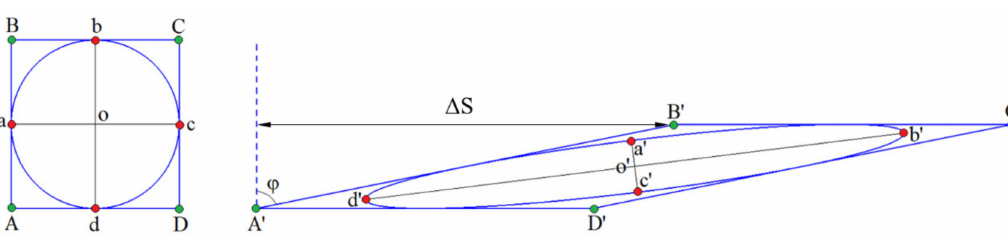
Figure 24. Schematic illustration of simultaneous pure and simple shear during asymmetric rolling.